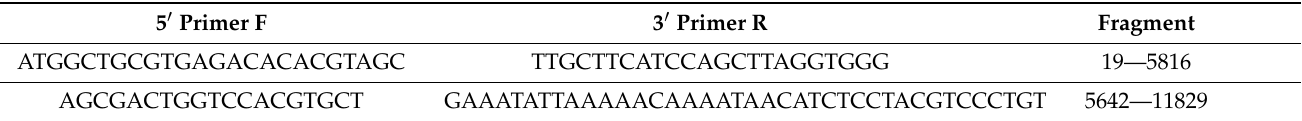
Table 1. Primers for CHIKV genome